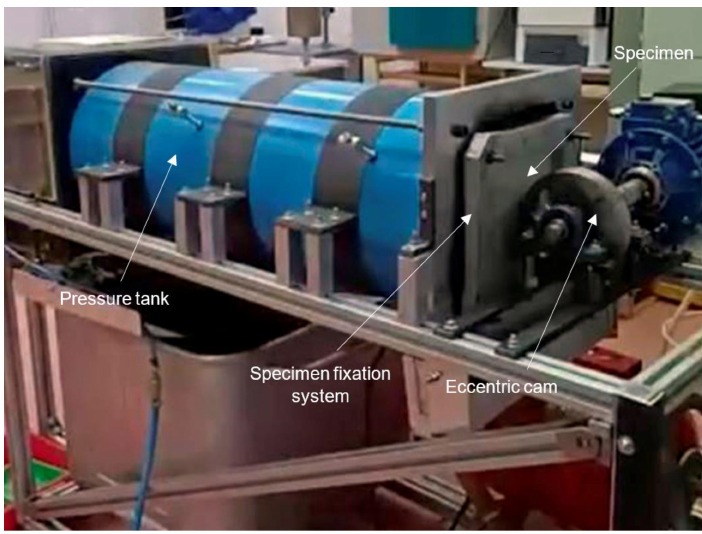
Figure 2. Test rig for the reproduction of slamming cycles, by means of an eccentric cam and pressurized water flow, on the composite test